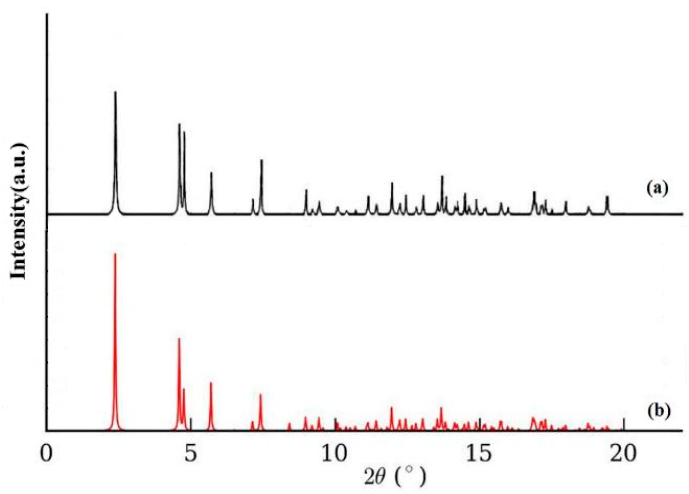
Figure 3. X-ray Powder Diffraction Pattern ( XRPD) of compound 1 ( a ) computed from single-crystal X-ray data and ( b ) from the nanorods .